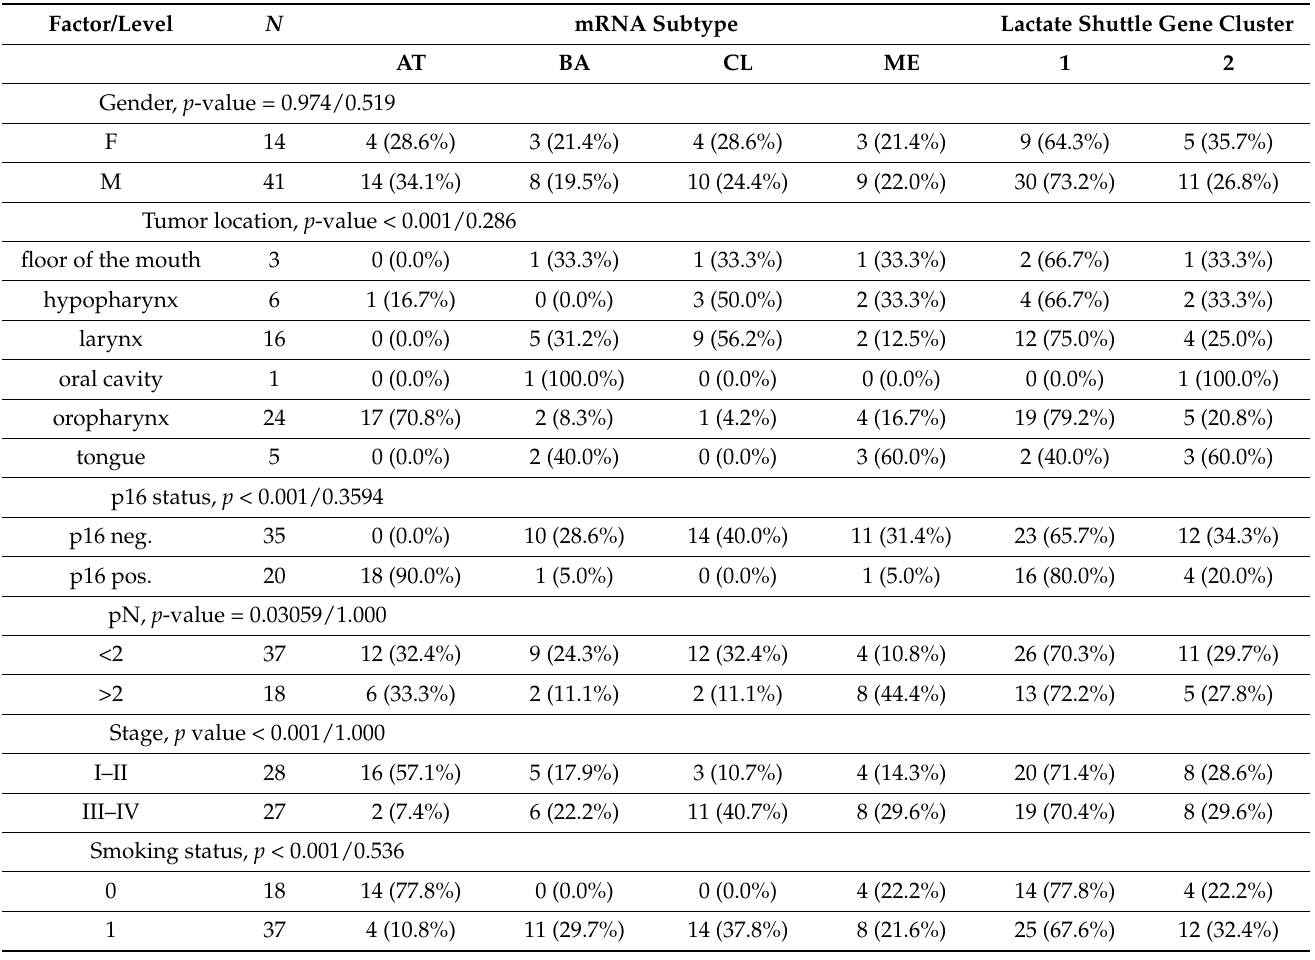
Table 1. Clinico-pathological characteristics of 55 patient cohort. Shown as number (% per group). p -values for Fischer exact test for factor vs. mRNA subtype and for a lactate shuttle-relevant gene expression clusters (see further in Figure 5), respectively. AT, atypical, BA, basal, CL, classical, ME, mesenchymal. N, number of